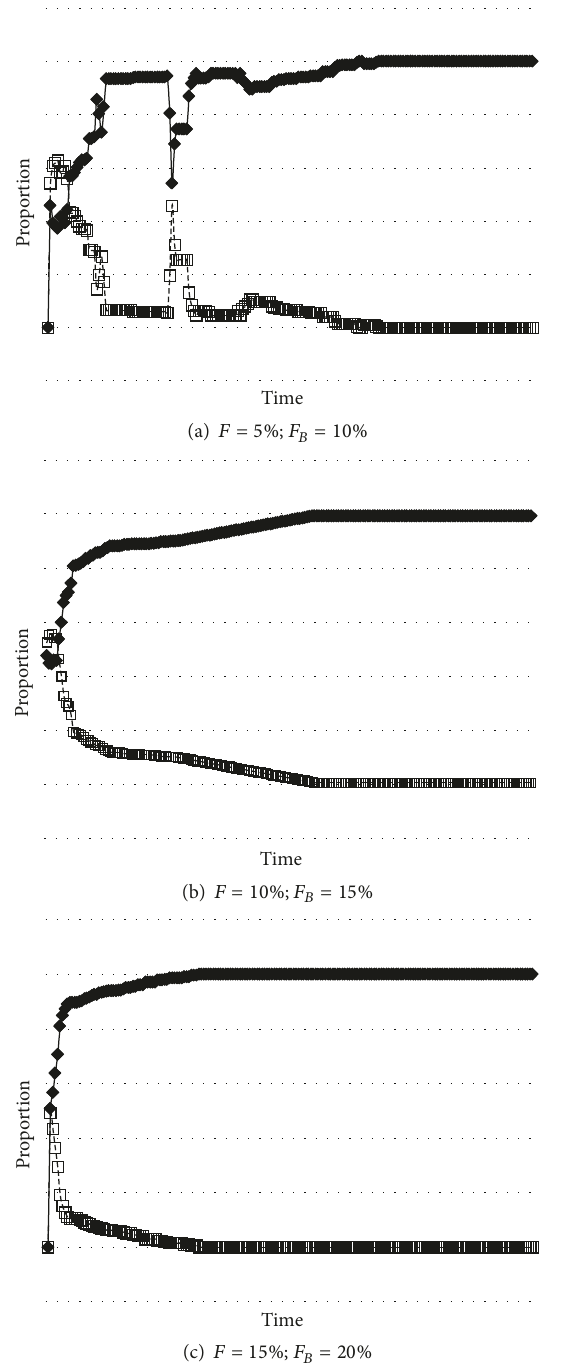
Figure7:Theevolutionarytrendoftheproducers’strategyselection in model III.